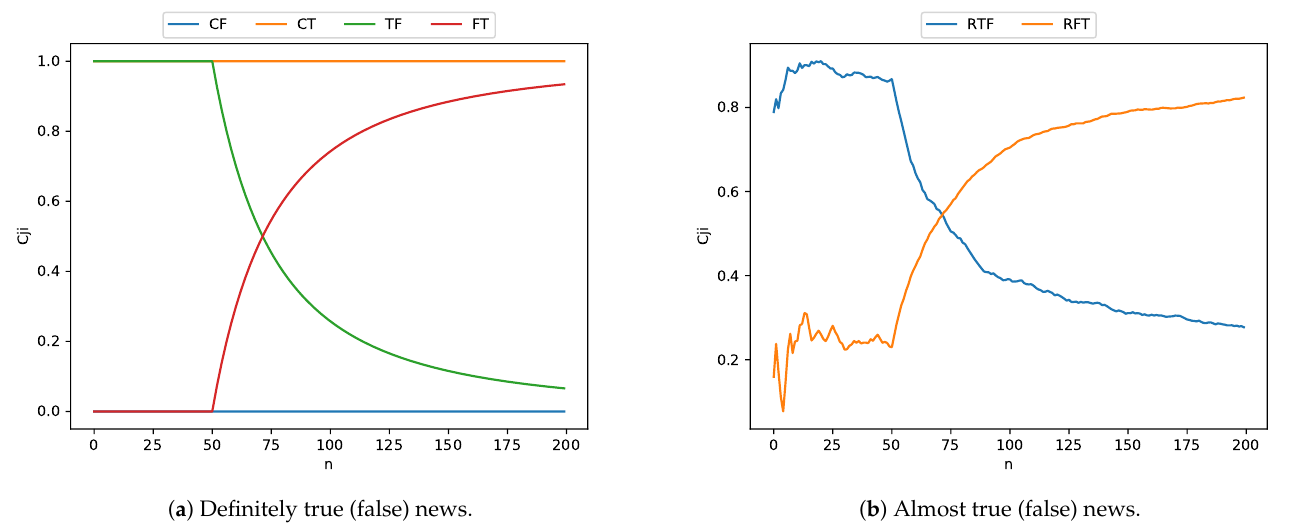
Figure 2. Direct credibility C ji dynamics, x-axis shows the time and y-axis the node